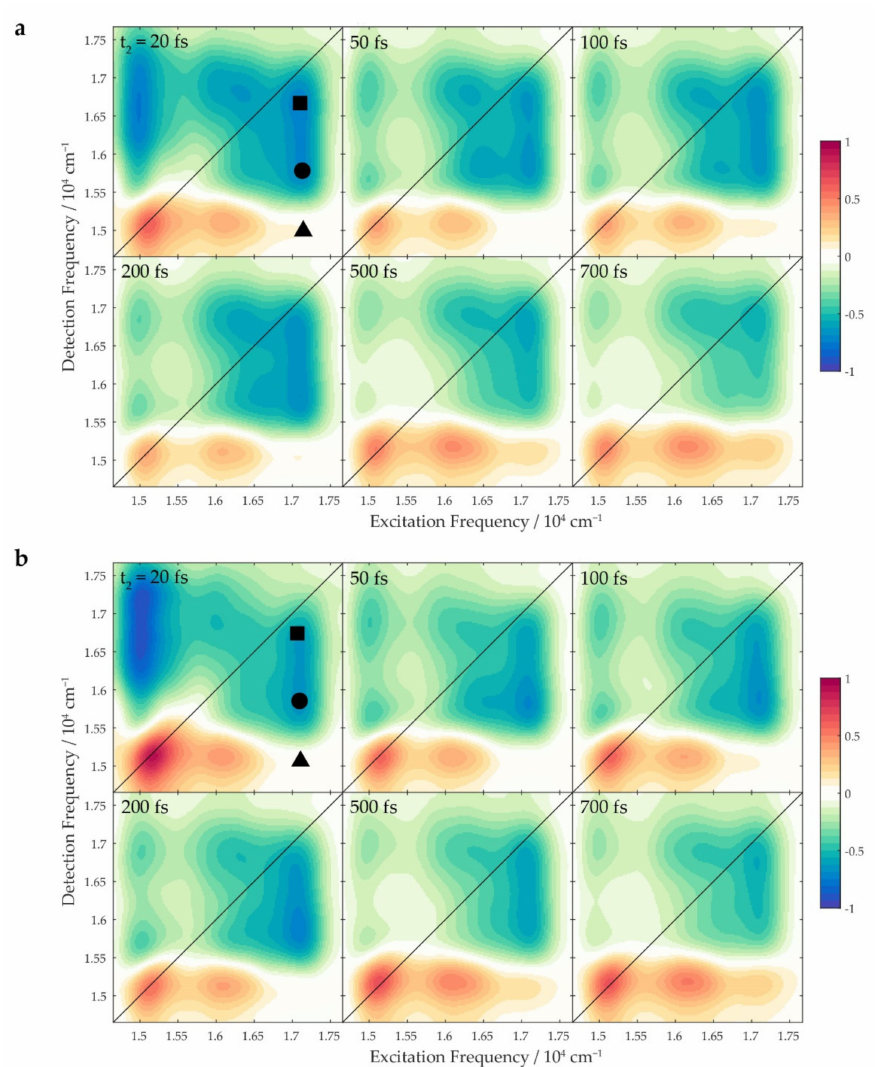
Figure 2. Absorptive 2DES maps of ( a ) WT PCP and ( b ) N89L PCP at different population times (t 2 ); to make the evolution of the populations more evident, the oscillating contributions to the signal were attenuated using a Savitzky–Golay filter. The markers pinpoint relevant coordinates discussed in the main